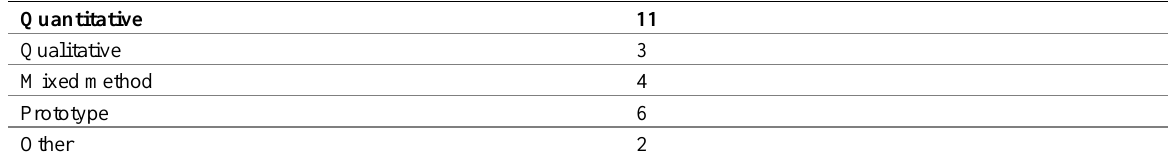
Table 2: Approaches used in the studies